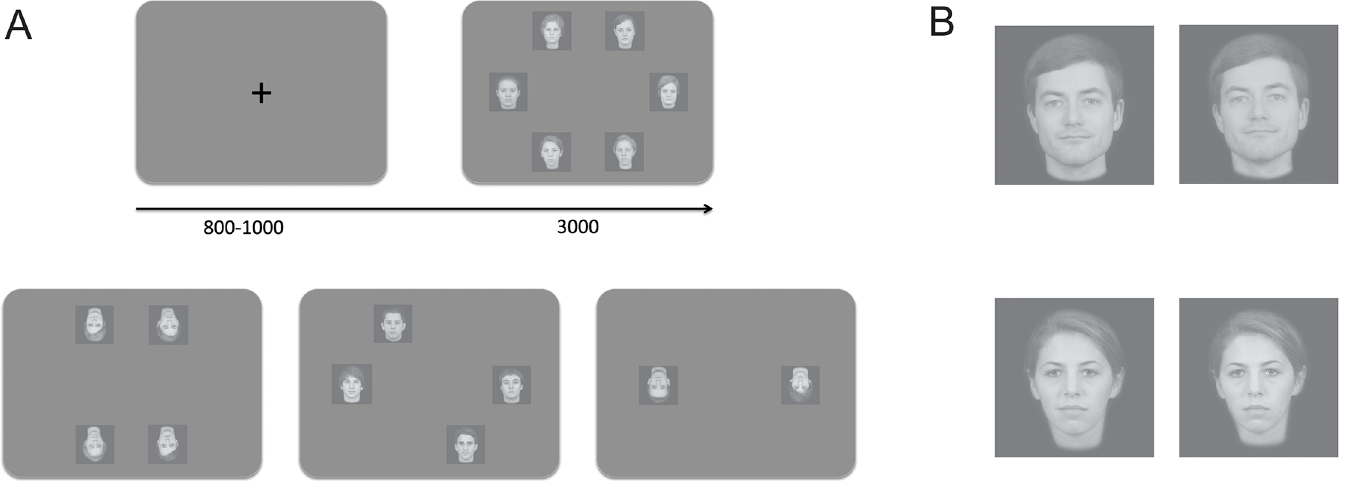
Fig 1. Experimental paradigm and example of the stimuli. A. On each trial, a central fixation cross appearedfor a jittered period between800–1000 ms, followedby a visual search array of two, four, or six faces displayedfor a maximum of three seconds. B. Two different images of each identity were shown throughoutthe